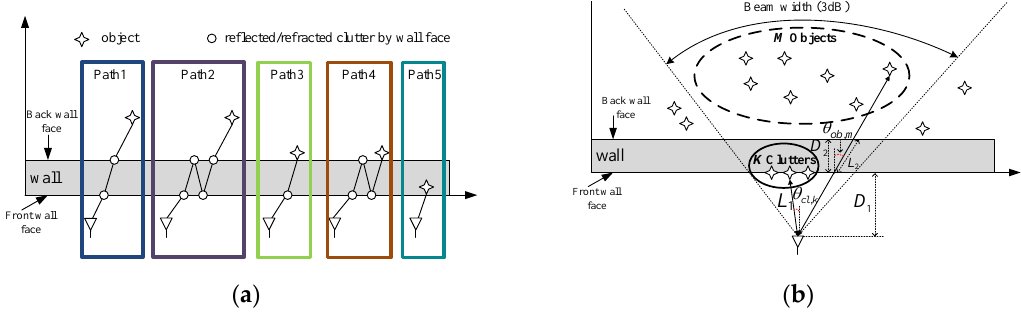
Figure 1. Geometry of TWRI system, ( a ) practical models of wave propagation, ( b ) simplified model for proposed algorithm.